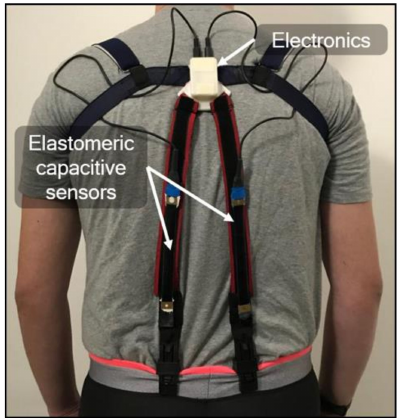
Figure 1. Picture of the assembled wearable system, based on two capacitive stretch